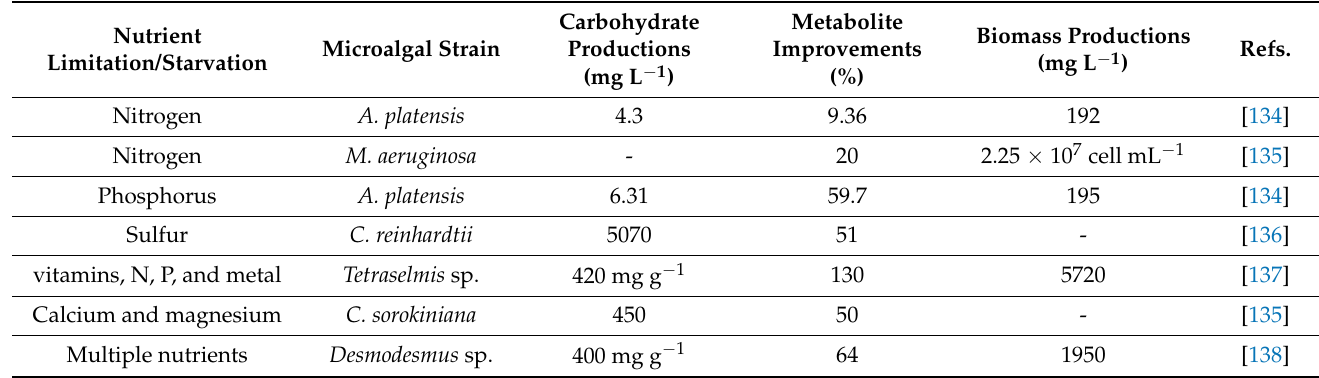
Table 4. Effect of nutrient limitations on microalgae biomass productivity and metabolite improve- ment.